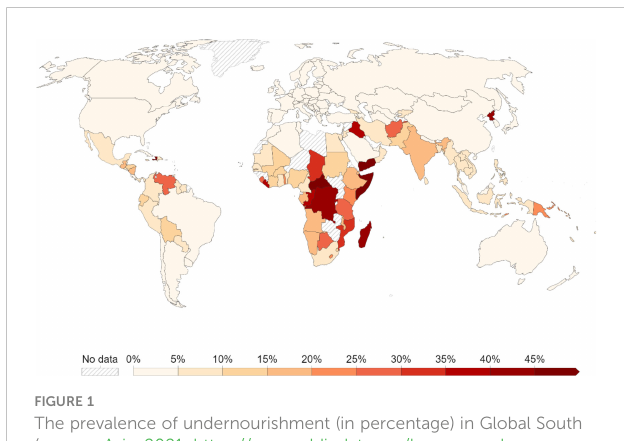
FIGURE 1 The prevalence of undernourishment (in percentage) in Global South (source: Asia, 2021; https://ourworldindata.org/hunger-and-